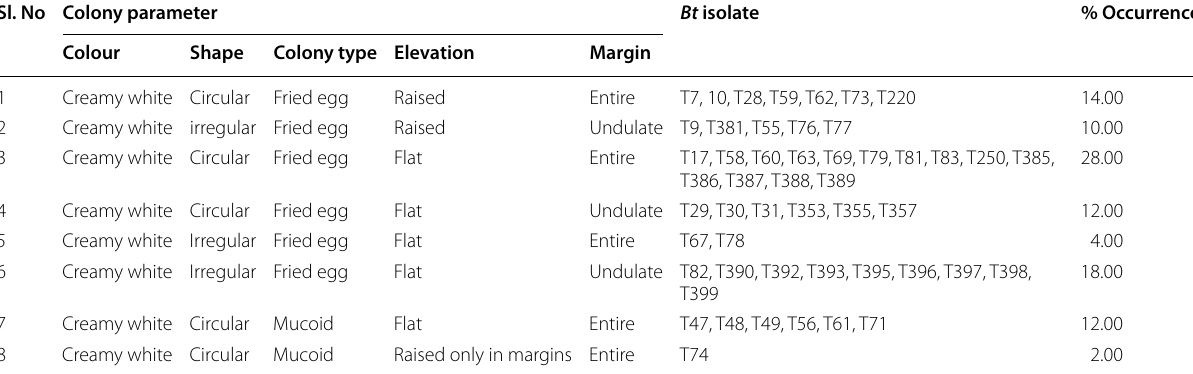
Table 1 Colony morphology of indigenous Bt isolates